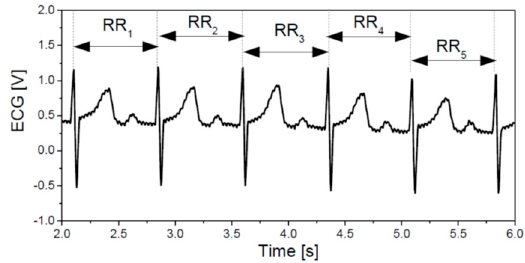
Figure 1. ECG signal showing six heart-beats and six intervals between the successive R peaks (RR intervals); in this Figure RR and NN intervals are identical as there are no artifacts.